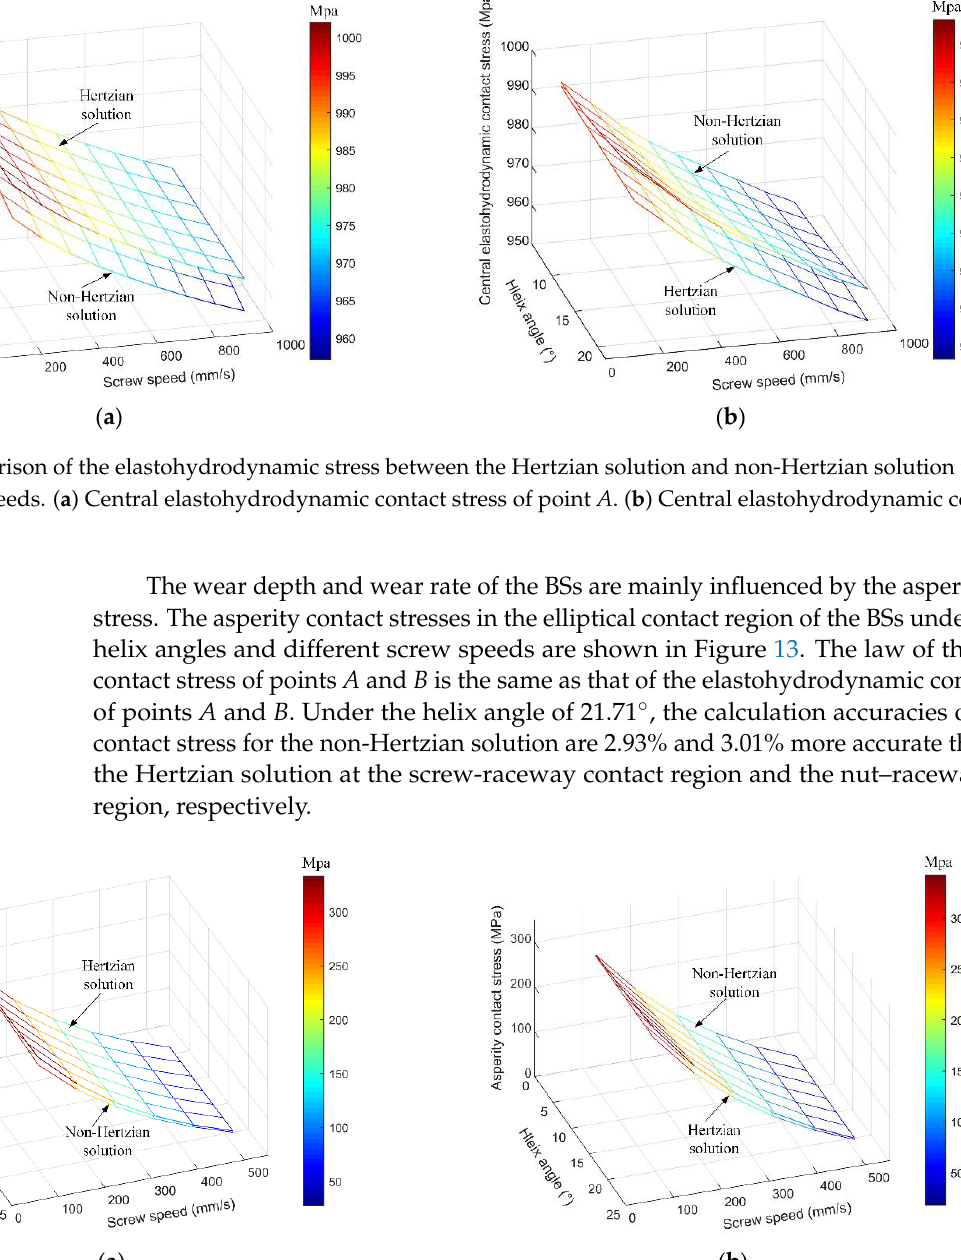
Figure 13. Comparison of the asperity contact stress between the Hertzian solution and non-Hertzian solution under different screw speeds. ( a ) Central asperity contact stress of point A . ( b ) Central asperity contact stress of point B .